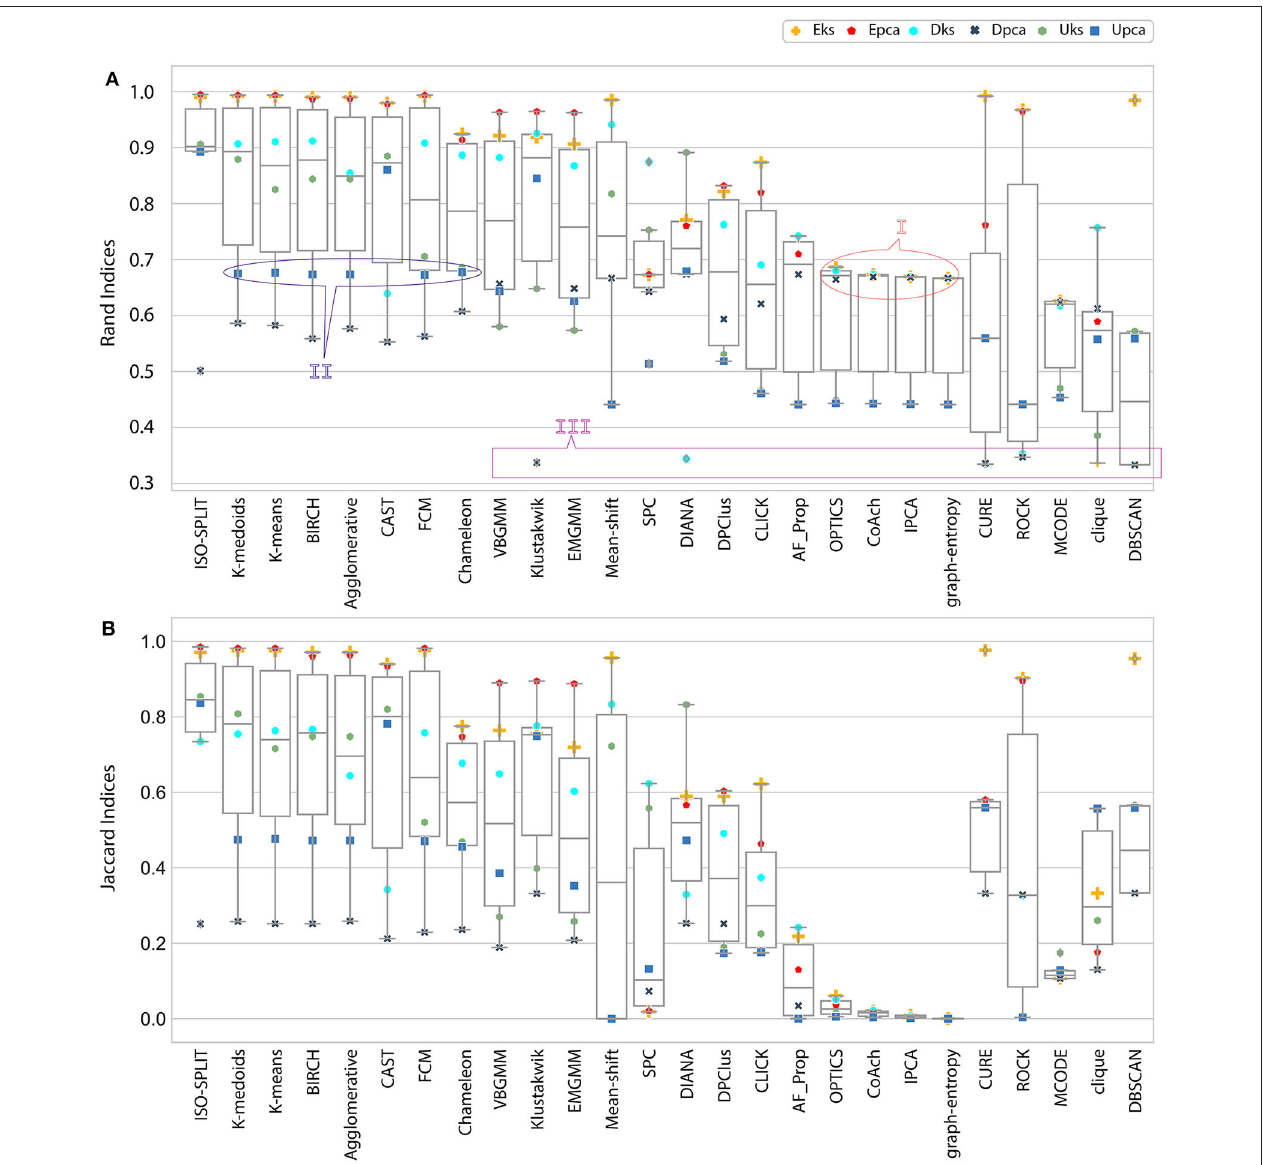
FIGURE 4 | Result of external indices. (A) Rand indices, annotations (I, II) refers to a case of confusion whether to be categorized as either good performance or bad performance and annotation III refers to another case where only one cluster was generated (section 5 discusses all annotated cases in detail). (B) Jaccard indices. Index value of zero indicates no cluster was